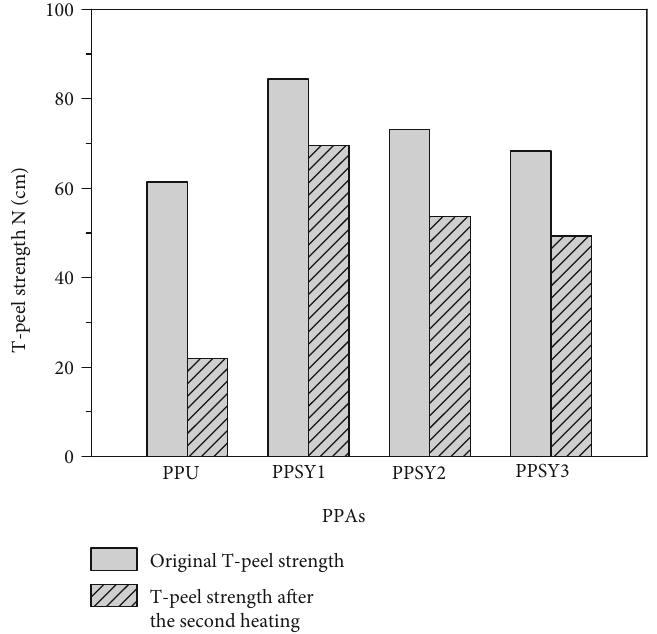
Figure 10: The e ff ect of nanosilica content on the T-peel